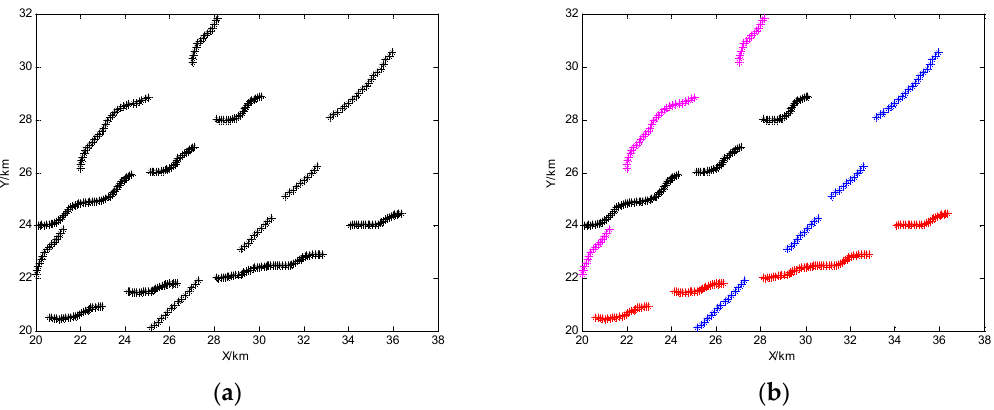
Figure 5. Results of a simulation experiment: ( a ) track segments obtained by a conventional tracking method; ( b ) association results of the proposed method.